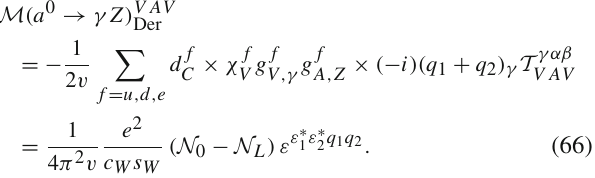
from the V (∂ μ a 0 ) − V (γ ) − A ( Z ) triangles, with the axion vector couplings of Eq. (54). Using again Eq. (30) but this time with a = b = 1 to preserve SU ( 2 ) L ⊗ U ( 1 ) Y ,